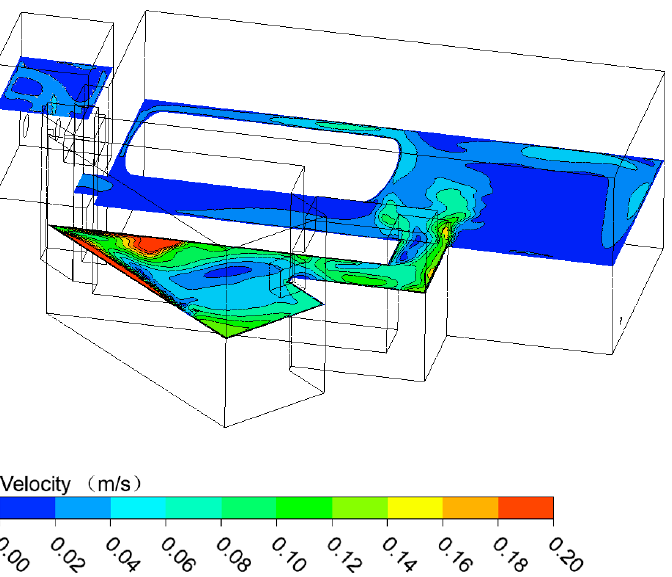
Figure 6. Velocity contour of layout scheme 12 (The scattering room z = 1.6 m and the sample room z = 2.4 m).